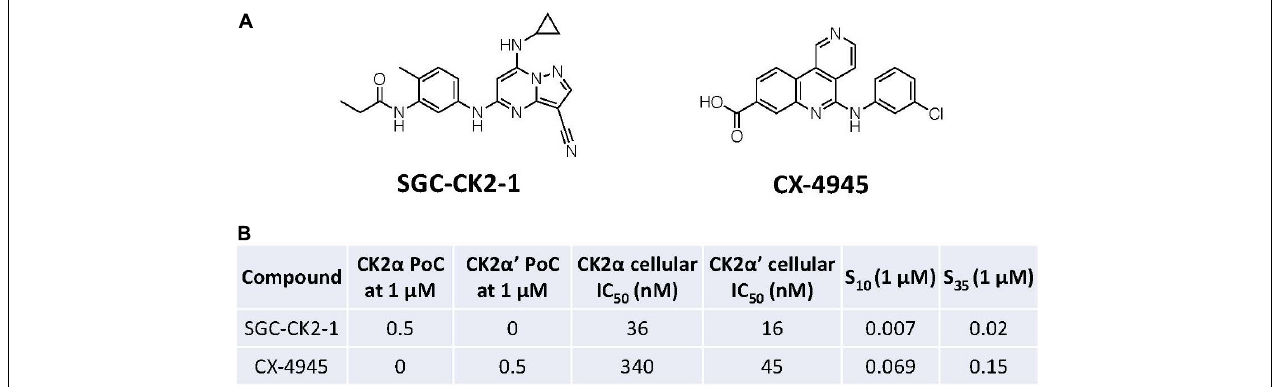
FIGURE 1 | Summary of CK2 inhibitor data. (A) Structures of SGC-CK2-1 and CX-4945. (B) Table of published kinome-wide selectivity scores (S 10 and S 35 ), CK2 α and CK20’ binding assay data (PoC at 1 µ M), and CK2 α and CK2 α ’ cellular target engagement (NanoBRET) IC 50 values for SGC-CK2-1 and